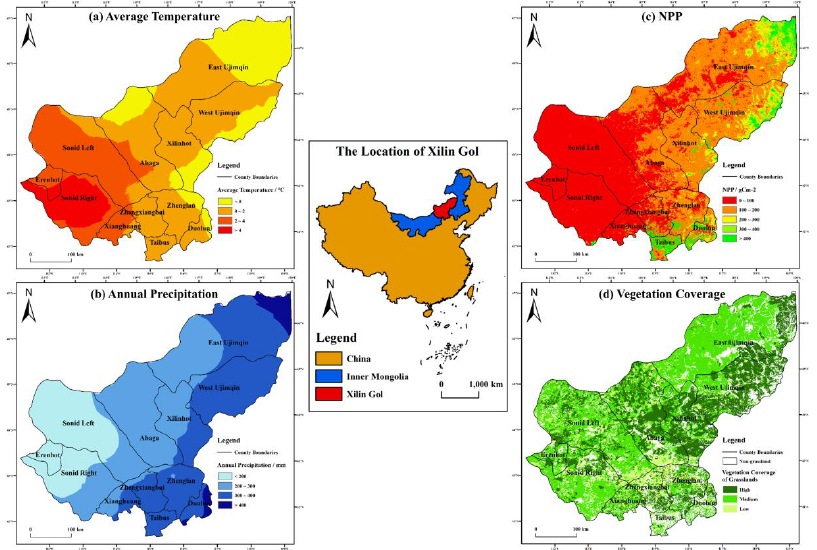
Figure 1 Figure 1. ( a ) The average temperature, ( b ) annual precipitation, ( c ) NPP and ( d ) vegetation coverage in Xilin Gol